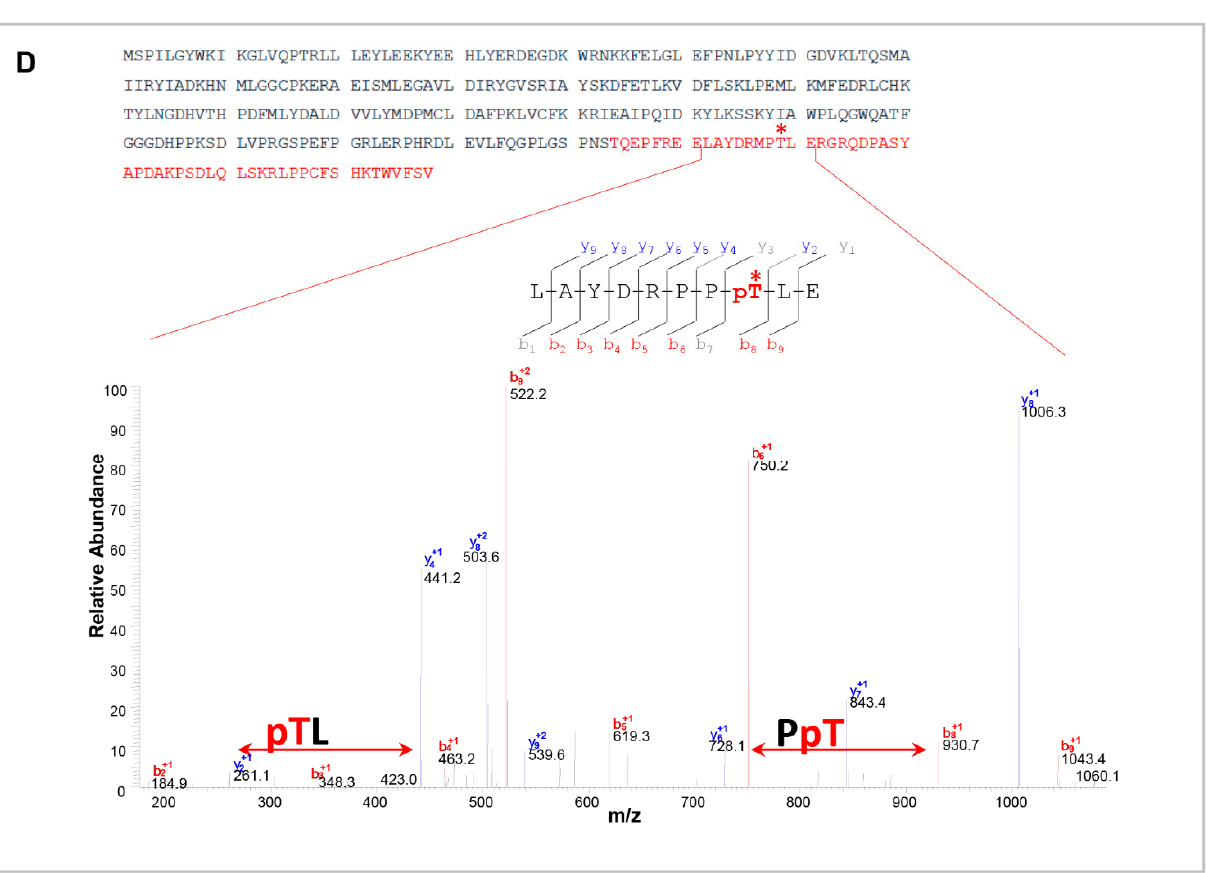
Figure 2. CaMKII phosphorylates threonine 17 residue in the MLC1 NH 2 terminal domain. ( A – C ) In vitro kinase assay using CaMKII enzyme immunoprecipitated from U251 cells. The not-specific substrate MBP ( A ), the His-MLC1 full-length protein (FL, ( B )), or the sepharose-immobilized GST- MLC1 NH 2 -terminal domain (MLC1 N-t, ( C )) were incubated with the CaMKII enzyme, with or without the CaMKII inhibitor KN93, and the reaction was carried out in the presence of [ γ 32 P] ATP. The [32P]-labeled proteins revealed by autoradiography indicated that MLC-FL and MLC1 N-t were specifically phosphorylated by CaMKII. ( D ) Mass spectrometry analysis of the phosphorylated MLC1 NH 2 terminal peptide after GluC digestion. In the upper part of the figure, the sequence of GST-MLC1 NH 2 -terminal region is shown, with the MLC1-NH 2 -terminus highlighted in red. The lower panel shows the MS3 spectrum of the double-charged phosphorylated peptide LAYDRMPTLE obtained after phosphoric acid loss caused by CID fragmentation. This neutral loss confirmed the presence of a phosphorylated site. B and Y series ions (reported in red and blue, respectively) in the MS3 spectrum localize the phosphorylation at T17. Phospho-T (pT) in the peptide sequence indicates a phosphorylated T, while the asterisk marks the localization of the pT in the sequence of MLC1-N-terminal.